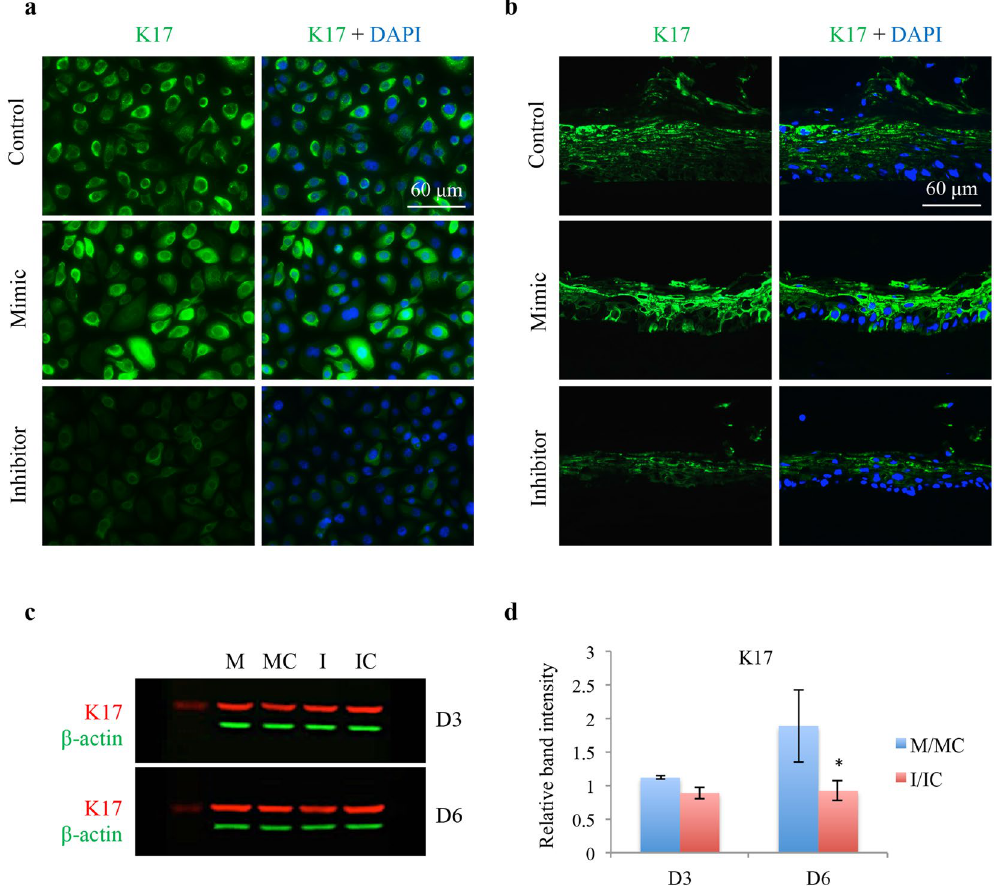
Figure 7. Effect of miR-10b on LEC marker K17 expression in HCEC and in normal human organ-cultured corneas by immunostaining and western blot. ( a ) Transfection with miR-10b increased, whereas with miR- 10b inhibitor decreased staining for K17 in HCEC compared to their corresponding controls. ( b ) MiR-10b treatment in human organ-cultured corneas led to increased expression of K17 compared to scrambled mimic control or Inhibitor. The same exposure time was used for each set of compared immunostained sections, and the assessment was done by more than one observer. The pictures are representative of two to three independent experiments. ( c ) Western blot analysis, total extracted protein from transfected HCEC with miR- 10b mimic (M) or its inhibitor (I) and their corresponding controls, mimic control (MC) and inhibitor control (IC), respectively, was separated on gradient SDS-PAGE gels, transferred to membrane and probed with K17 antibody (Table 2). Antibody to β -actin was used as loading controls and for semi-quantitation. miR-10b treatment decreased, whereas its inhibitor increased, protein level of K17. ( d ) Quantitation of K17 protein level. The bar graph represents average ± SEM of pooled values (n = 4) of densitometric scans. * P < 0.05, compared with scrambled control values by paired two-tailed t